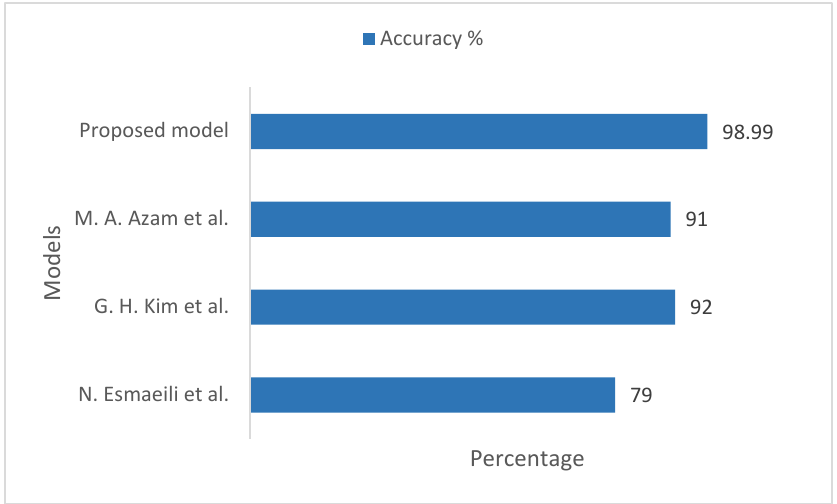
Figure 7. Comparison of accuracy between the proposed model and existing models, taking into account the ImageNet datasets [33–35].